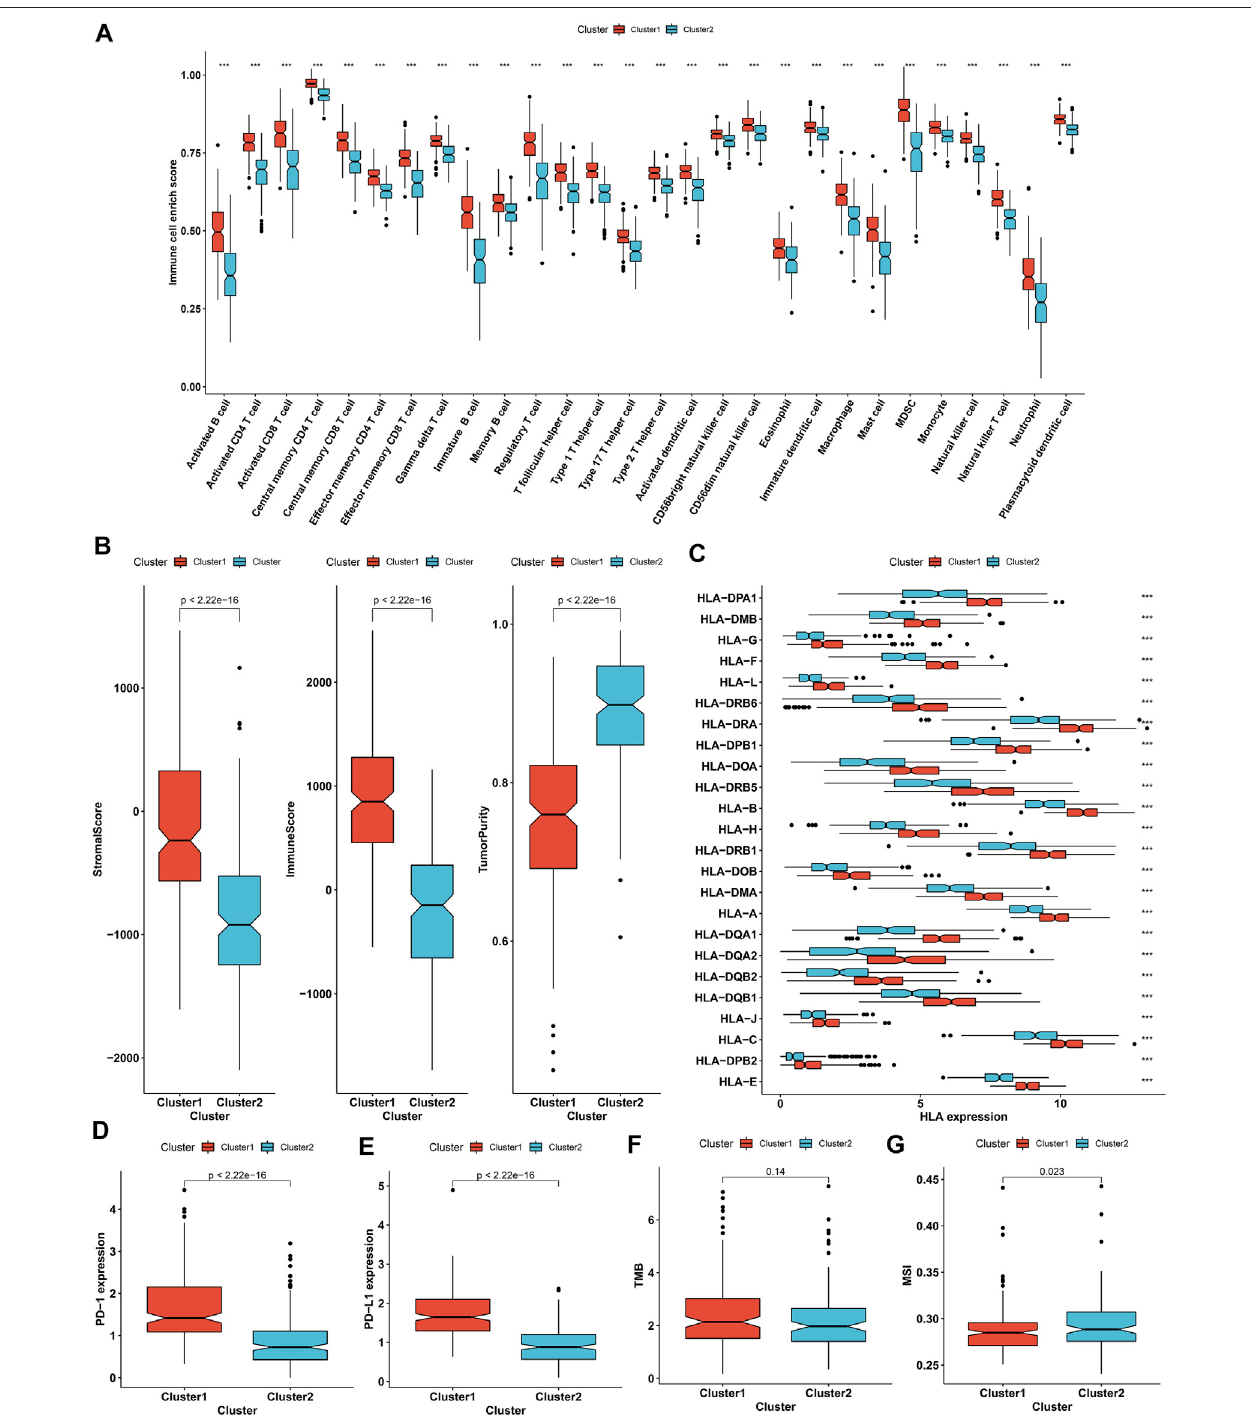
FIGURE 3 | Two immune subtypes with disparate immune in fi ltrates and immune response across OC patients. (A) The ssGSEA identifying the difference in immune in fi ltrates between immune subtypes 1 and 2. (B) ESTIMATE inferring the difference in stromal and immune scores and tumor purity between two immune subtypes. (C) Comparison of the difference in expression of MHC molecules between two immune subtypes. (D,E) Box plots presenting the difference in expression of PD-1 and PD-L1 between two immune subtypes. (F,G) Estimation of the difference in TMB and MSI scores between two immune subtypes. *** p < 0.001.